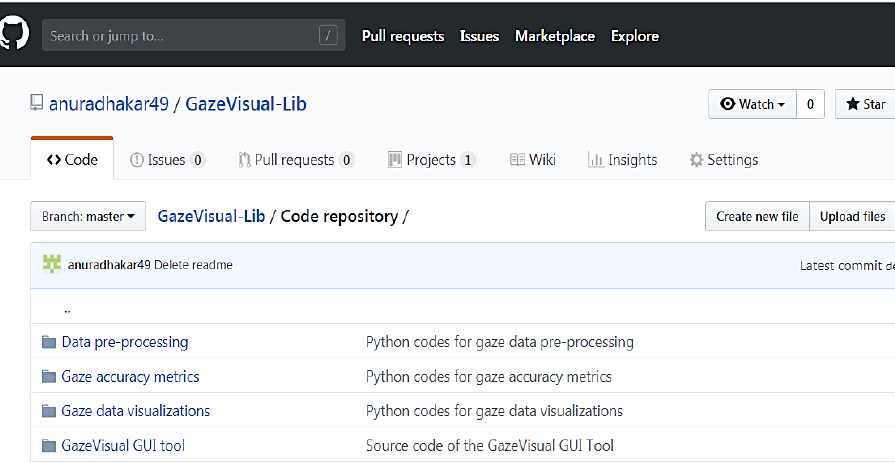
Figure 2. View of the GazeVisual-Lib code repository on GitHub.